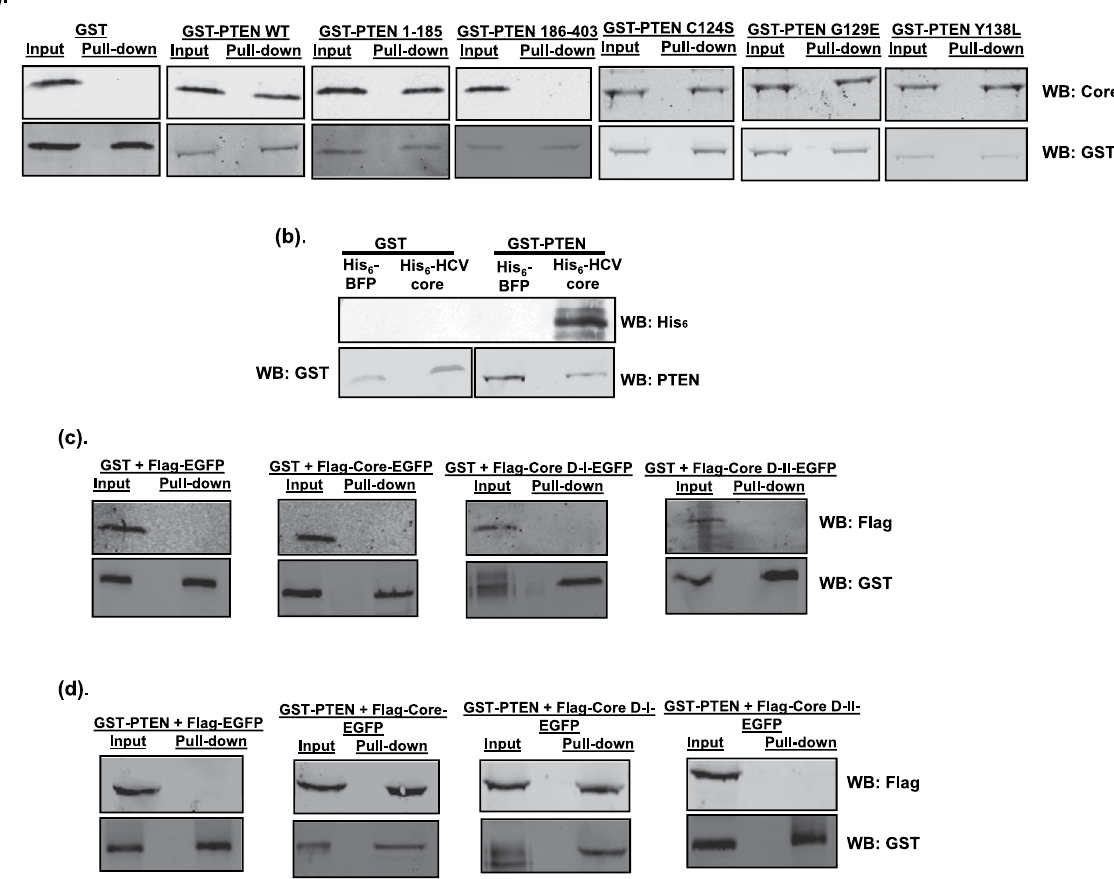
Figure 5. PTEN interacts with the domain I of HCV core. ( a ) Huh-7 cells harboring HCV-2a J6/JFH-1(p7- rLuc-2A) replicon were transfected with plasmids expressing GST, GST-PTEN wild-type or GST-PTEN mutants. At 48 hours after transfection, cell lysates were subjected to GST pull-down assay. Input and pull-down products were analyzed by Western blotting (WB) using anti-HCV core and anti-GST antibodies, respectively. ( b ) Purified His 6 -BFP (blue fluorescent protein), His 6 -HCV core, GST and GST-PTEN proteins were subjected to GST pull-down assay. Pull-down products were analyzed by Western blotting (WB) using anti-His 6 , anti- GST and anti-PTEN antibodies, respectively. Western blot image with a “shorter exposure” can be found in the Supplementary Information. ( c and d ) Huh-7 cells were co-transfected with plasmids expressing Flag- tagged HCV core, either full-length, domain I (D-I; aa. 1–118), or domain II (D-II, aa. 119–178), together with plasmids expressing GST ( c ) or GST-PTEN ( d ). The core proteins were expressed as fusion proteins with EGFP. Flag-tagged EGFP-expressing plasmid was included as negative control. At 48 hours after transfection, cell lysates were subjected to GST pull-down assay. Input and pull-down products were analyzed by Western blotting (WB) using anti-Flag and anti-GST antibodies,